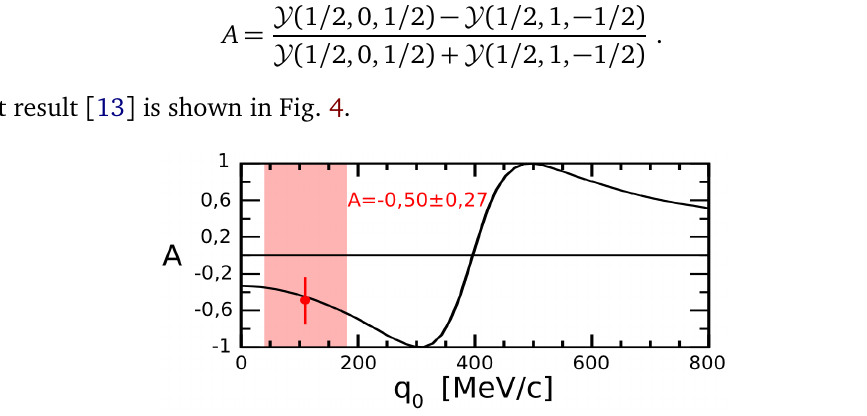
(cid:126) He ( (cid:126) e,e (cid:48) (cid:126) p )